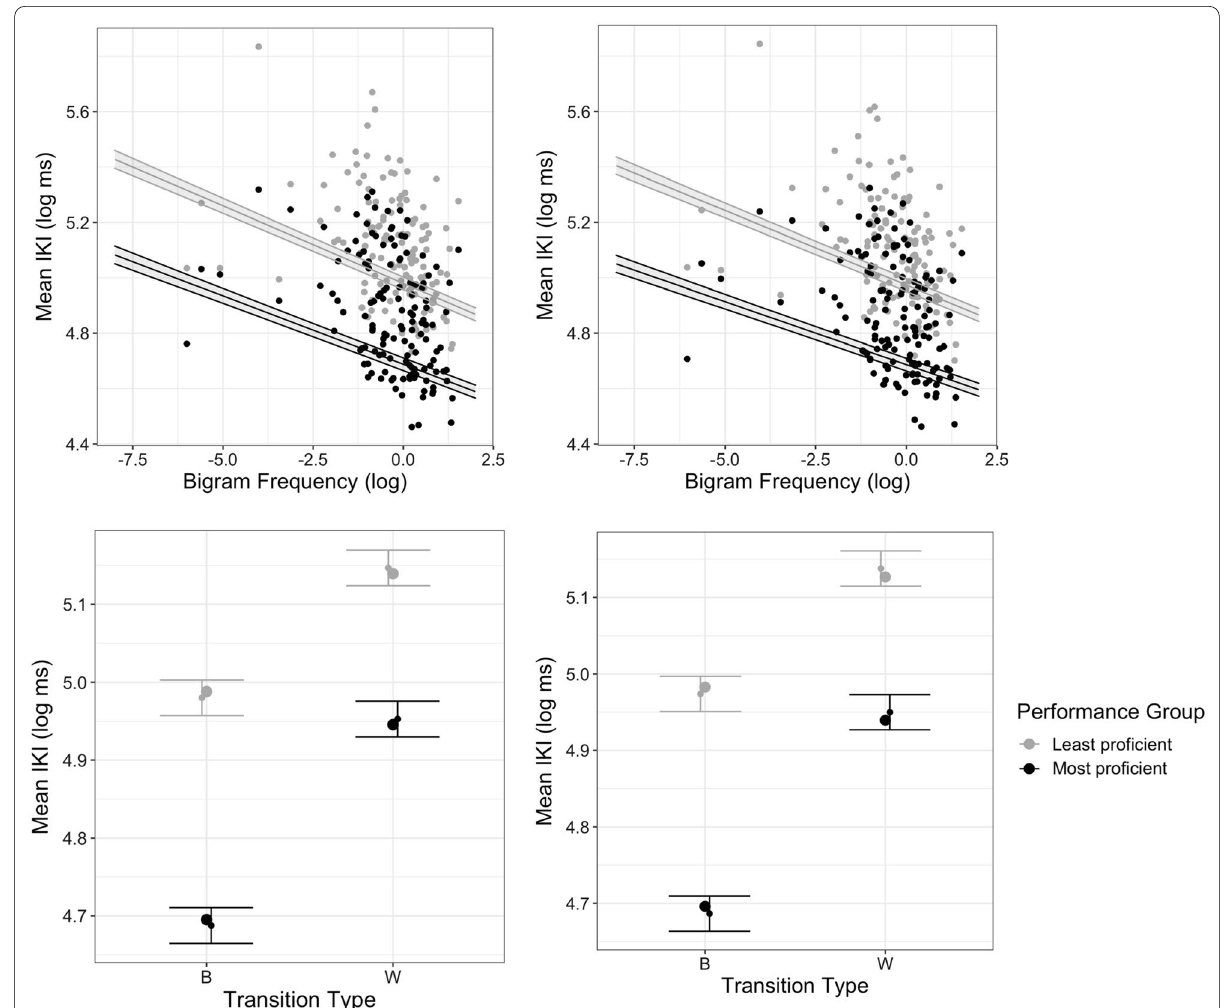
Fig. 6 Effect of bigram frequency (top) and transition type (bottom) on IKIs in picture naming (left) and word copying (right) tasks. IKIs are plotted in log scale, as they were entered in the model. Predicted effects from the mixed model analysis are plotted on top of the data with 95% confidence intervals (obtained from ggeffects package (Lüdecke, 2018)). Bigram frequency is centred and